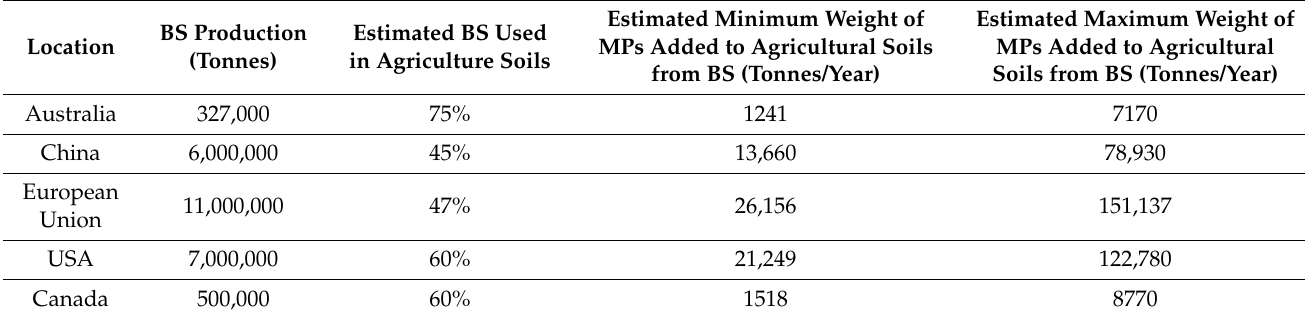
Table 3. Estimated weight of MPs added to agricultural soils in Australia, China, the European Union, the USA, and Canada; adapted from [38], with modifications.